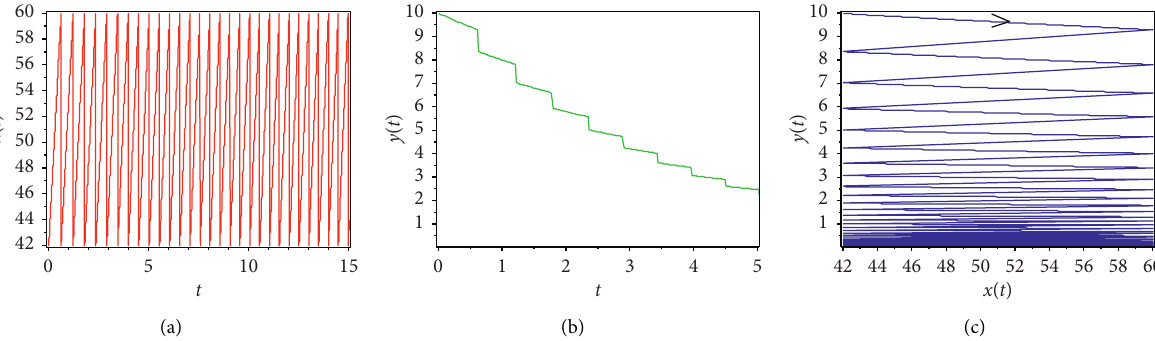
Figure 5: Numerical simulations when c � 0. (a) Time series of x ( t ). (b) Time series of y ( t ). (c) Phase portrait of x ( t ) and y ( t ).